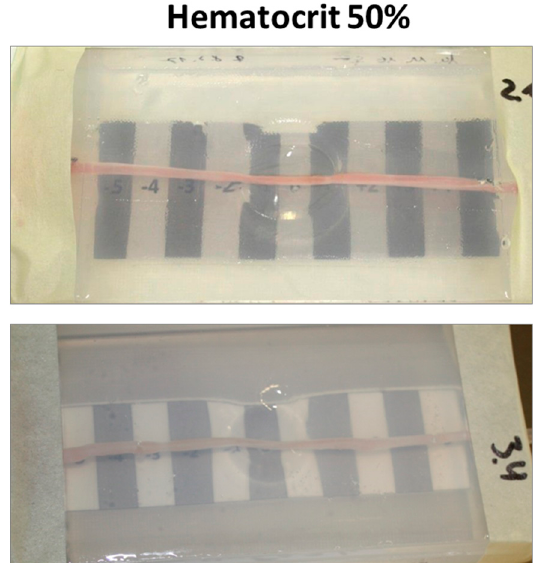
Figure A2. Representative macroscopic images of the artery models after the experiments with red blood cell (RBC) suspensions at 50% Ht.